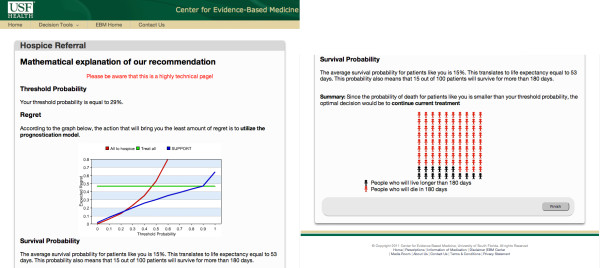
Justification of the hospice referral recommendation. The particular patient depicted has 29% threshold probability at which the optimal strategy is derived by the SUPPORT model. The patient has 85% probability of death in the next 180 days. Therefore, the optimal decision is to be referred to hopsice.